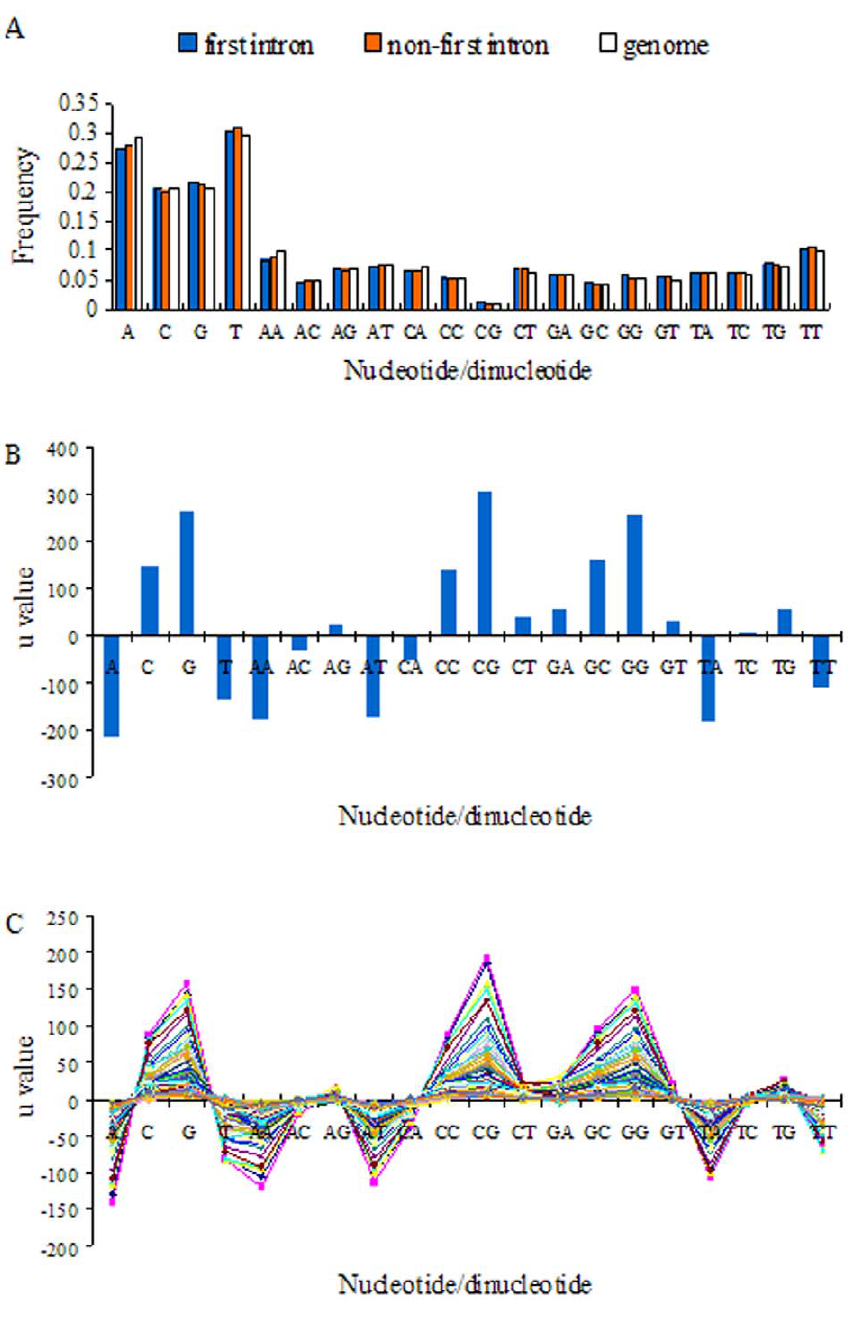
Figure 2. Occurrence frequencies of nucleotides and dinucleotides in introns. (A) Frequencies of nucleotides and dinucleotides in the first introns and non-first introns. (B) u-values of nucleotides and dinucleotides in the first introns relative to the non-first introns. (C) u-values of nucleotides and dinucleotides in the first introns relative to the non-first introns at different positions. One colored polyline represents a group of u- values of all kinds of nucleotides and dinucleotides for the first introns vs. the non-first introns in one specific position. Since we only focus on whether some nucleotides and dinucleotides are over-represented in the first introns, the differences of nucleotide or dinucleotide content between any two position-specific non-first introns do not be